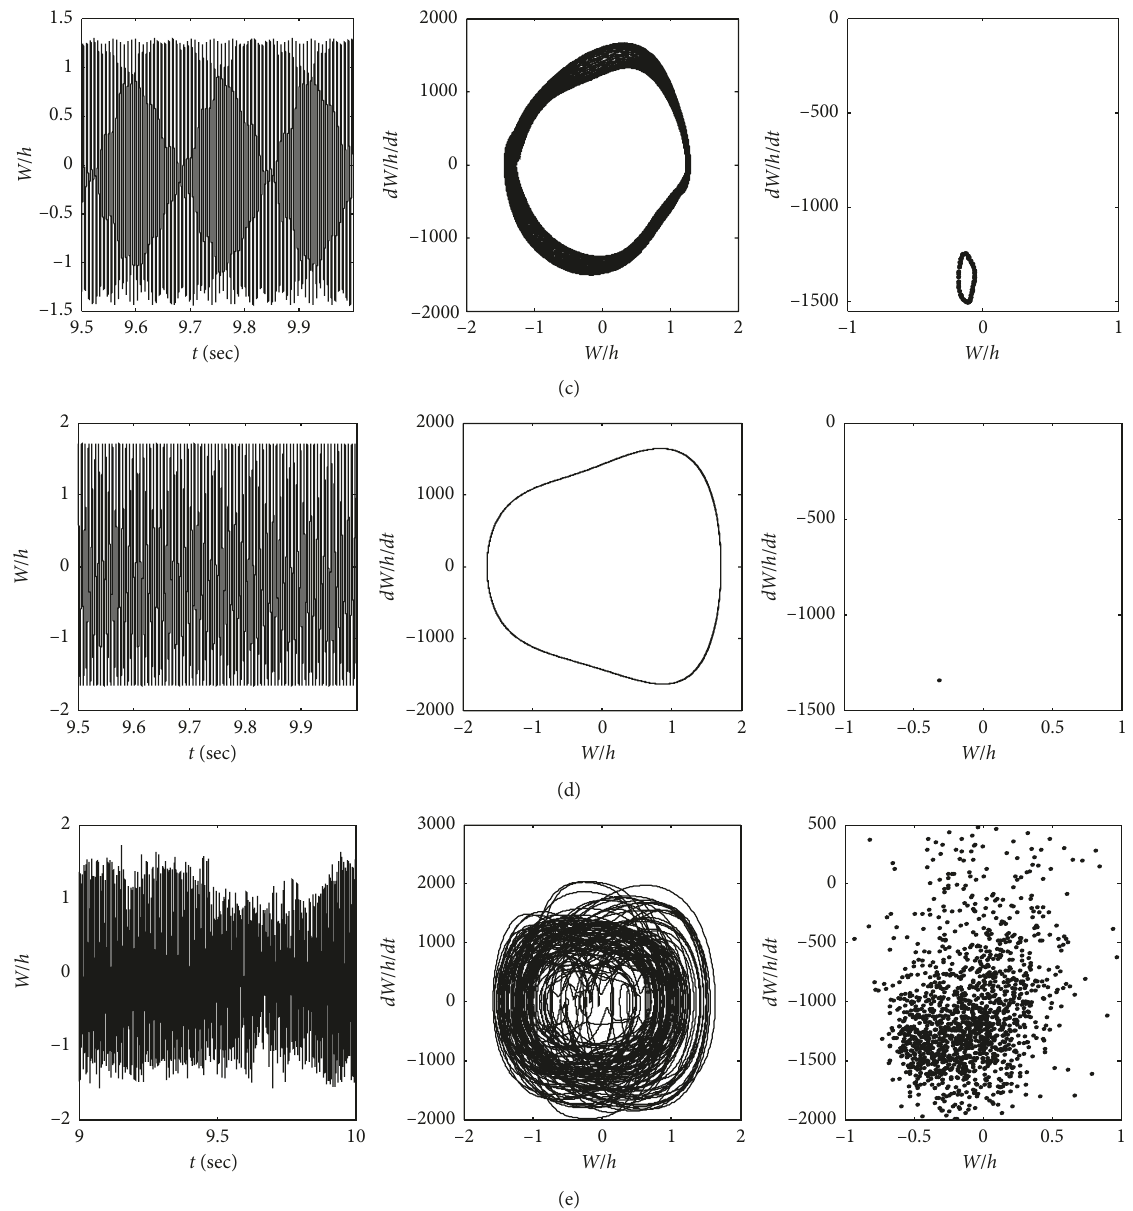
Figure 6: Time history, phase portrait, and Poincar´e maps under different dynamic pressures. (a) λ � 240. (b) λ � 250. (c) λ � 780. (d) λ � 930. (e) λ �